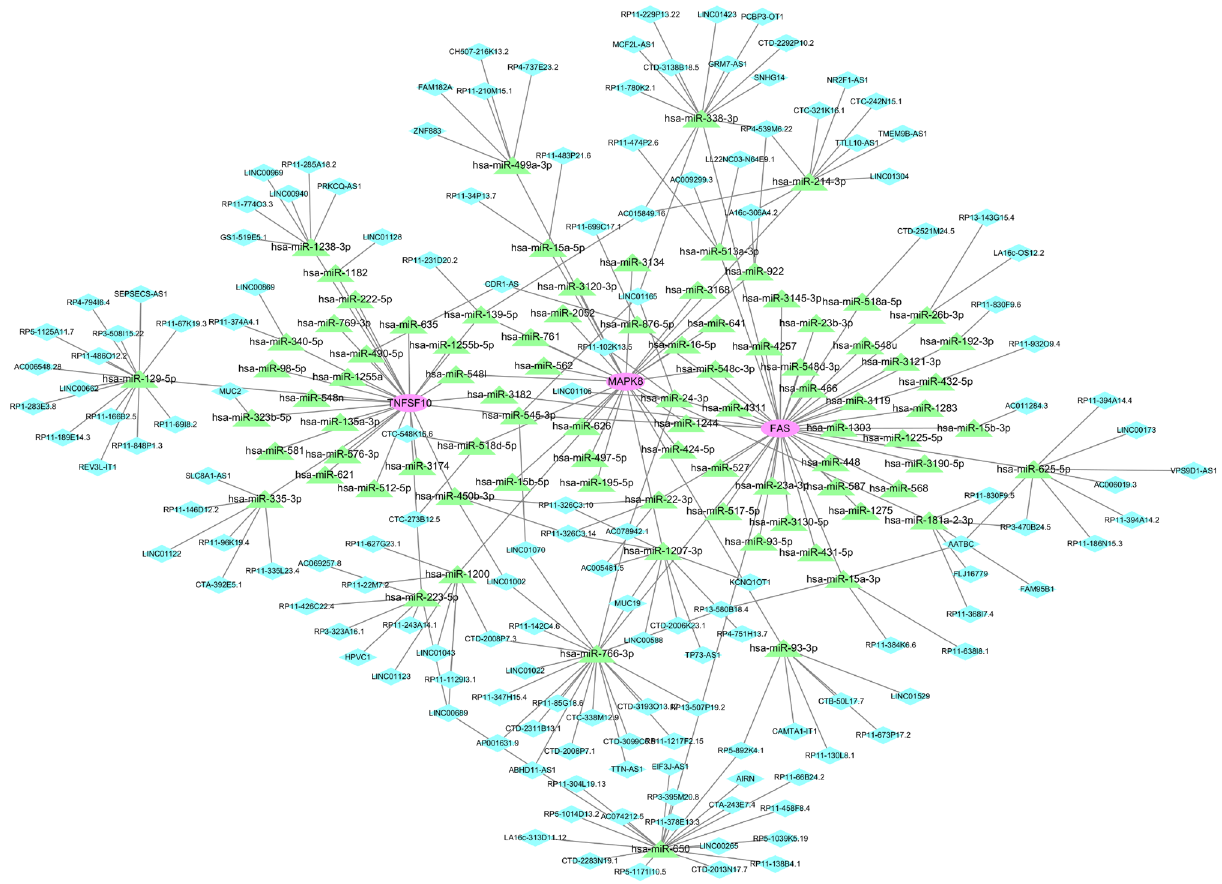
Figure 8. Key gene ceRNA network map. The network includes 238 nodes (3 key genes, 87 miRNAs and 148 lncRNAs) and 264 edges.